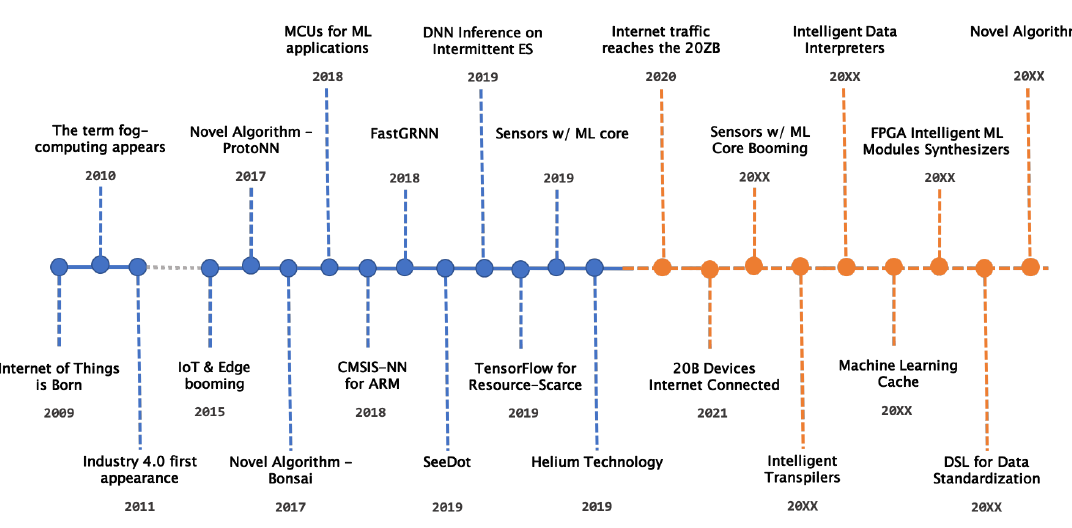
Figure 9. ML in embedded systems road map and future